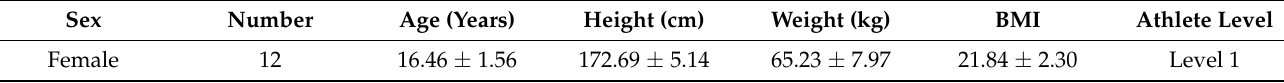
Table 1. Baseline data of athletes (X ±